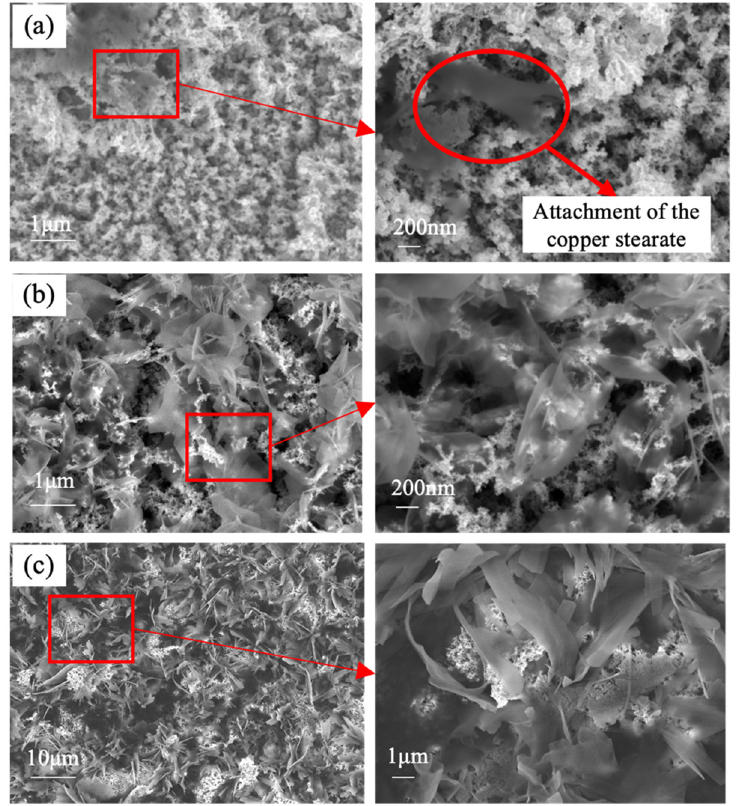
Figure 6. SEM images of the superhydrophobic surface at different modification times: ( a ) 5 min; ( b ) 15 min; ( c ) 120 min.